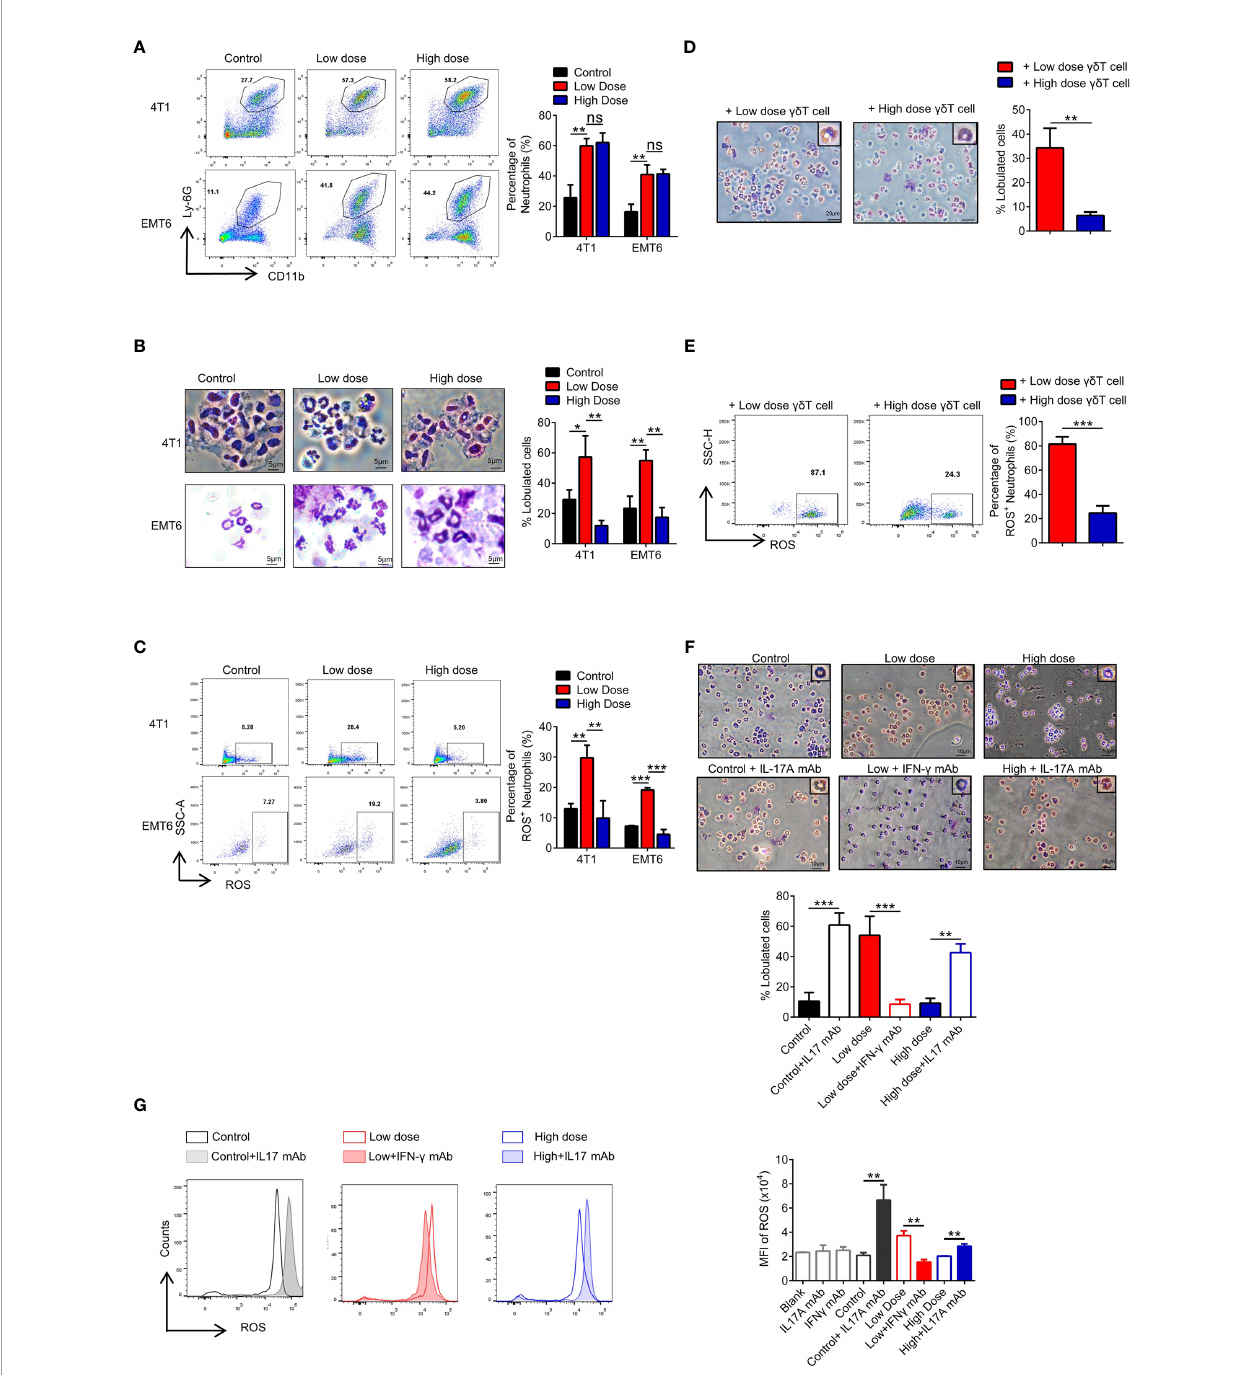
FIGURE 4 | High-dose VEGFR2-TKI therapy facilitates N2-like neutrophils by IL17A-producing gd T cells. (A) Flow cytometry analysis of the percentage of neutrophils (CD45 + CD11b + Ly-6G + ) in the tumor after VEGFR2-TKI therapy. (B) Giemsa-stained neutrophils from the tumor after VEGFR2-TKI therapy in vivo . Bar=5 m m. (C) Reactive oxygen species (ROS) production of neutrophils in the tumor after VEGFR2-TKI therapy in vivo . (D, E) Representative images of Giemsa nuclear morphology analysis (D) and Frequency of ROS expression (E) of naive bone marrow (BM)-derived neutrophils, which were co-cultured with gd T cells sorted from tumors after different dose of VEGFR2-TKI therapy. Bar=20 m m. (F, G) Representative images of Giemsa nuclear morphology analysis (F) and MFI of ROS expression by fl ow cytometry analysis (G) in BM-derived neutrophils co-cultured with different tumor culture supernatants after VEGFR2-TKI therapy and (or) IL17 mAb or IFN- g mAb added in vitro . Bar=10 m m. Data are presented as the means ± SD from one representative experiment. Similar results were obtained from three independent experiments, n=4 mice each group, unless indicated otherwise. Statistical analysis was performed by two-tailed unpaired Student ’ s t test (A – E) and one-way ANOVA (F, G) . ns, not signi fi cant, *p < 0.05, **p < 0.01, and ***p < 0.001. See also Supplementary Figure S4